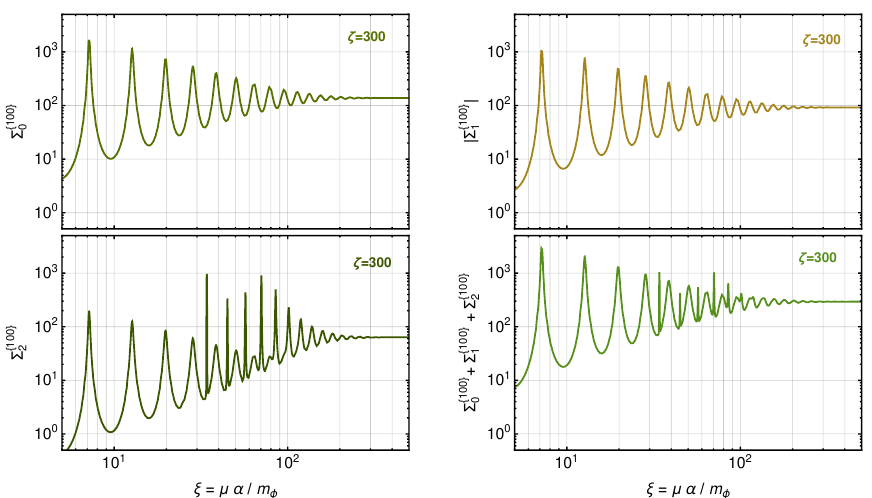
JHEP04(2017)077 Figure 10a . The factors (cid:6) f 100 g ( (cid:16); (cid:24) ), (cid:6) f 100 g ( (cid:16); (cid:24) ) and (cid:6) f 100 g ( (cid:16); (cid:24) ) that contribute to the cross- 0 1 2 section for the radiative capture of a particle-antiparticle pair, into the ground state, with emission of a scalar force mediator [cf. eqs. (4.10)]. The bottom panel shows their sum, which corresponds to S f 100 g if the phase-space suppression is negligible. (cid:6) f 100 g and (cid:6) f 100 g involve only the ‘ = 0 mode 0 1 BSF of the scattering-state wavefunction, while (cid:6) f 100 g includes contributions both from the ‘ = 0 and 2 ‘ = 2 components. The ‘ modes determine the resonances. Figure 10b . Velocity dependence of the various contributions to the cross-section for the radiative capture of a particle-antiparticle pair into the ground state, with emission of a scalar force mediator: (cid:6) f 100 g ( (cid:16); (cid:24) ) (dashed lines), (cid:6) f 100 g ( (cid:16); (cid:24) ) (dot-dashed lines), (cid:6) f 100 g ( (cid:16); (cid:24) ) (dot-dot-dashed lines), and 0 1 2 their sum (solid lines) [cf. eq. (4.10)]. Because (cid:6) f 100 g , (cid:6) f 100 g and (cid:6) f 100 g involve the ‘ = 0 mode of 0 1 2 the scattering-state wavefunction, they saturate to a constant value at low velocities. (cid:6) f 100 g contains 2 also a contribution from the ‘ = 2 mode; away from the Coulomb regime, this contribution decreases with decreasing velocity, and eventually becomes subdominant, as can been seen in the left panel. { 37